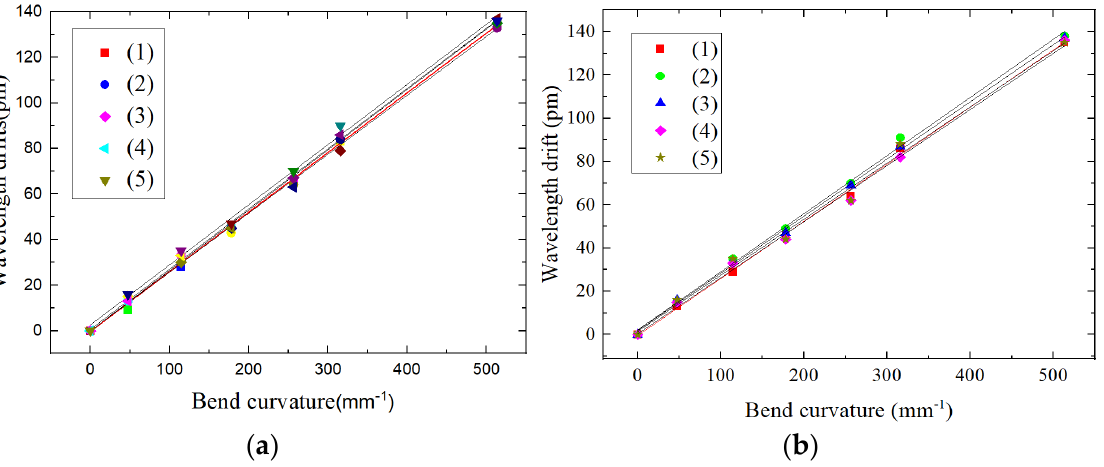
Figure 16. Shape sensor FBG error analysis of repeatability: ( a ) FBG1 center wavelength drift consistency, ( b ) FBG2 center wavelength drift consistency.